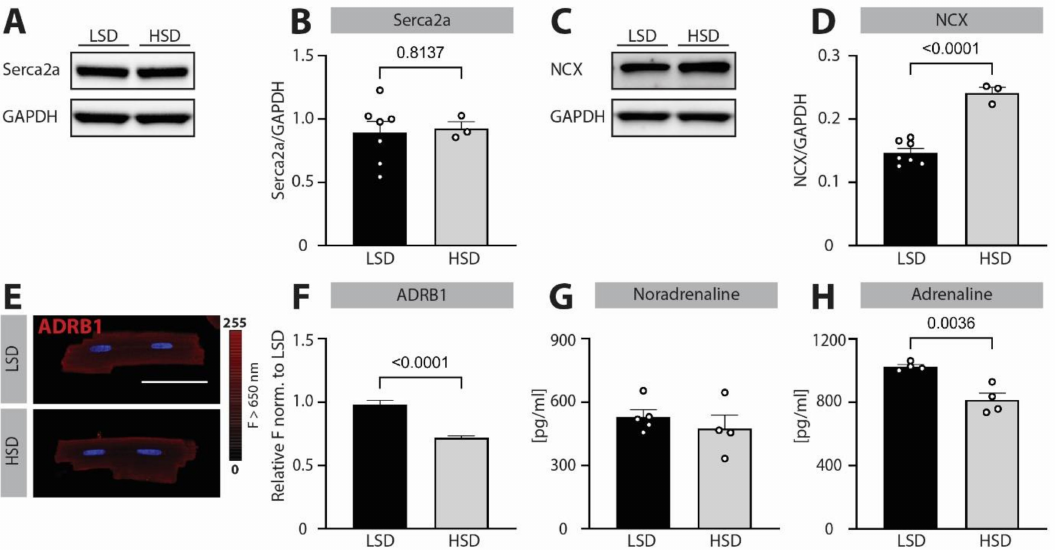
Figure 4. Hypertension is associated with blunted β -adrenergic signaling and increased NCX expression in Dahl salt-sensitive rats . ( A ) Representative bands of immunoblotted Serca2a and housekeeping protein GAPDH in cardiac tissue of Dahl salt-sensitive rats kept on low-salt diet (LSD) or high-salt diet (HSD) for 10 weeks. ( B ) Corresponding quantification of Serca2a expression, normalized to GAPDH. ( C ) Representative bands of immunoblotted NCX and housekeeping protein GAPDH in cardiac tissue of Dahl salt-sensitive rats kept on LSD or HSD for 10 weeks. ( D ) Corresponding mean values of NCX expression, normalized to GAPDH. ( E ) Representative fluorescent images of isolated cardiomyocytes immunostained against β -adrenergic receptor 1 (ADRB1). Scale bar indicates 50 µ m. ( F ) Mean fluorescent values for ADRB1 normalized to LSD. Mean values for ( G ) noradrenaline and ( H ) adrenaline plasma levels in Dahl salt-sensitive rats kept on LSD or HSD for 10 weeks. Data are shown as mean ± SEM ( N = 7/3 rats for LSD/HSD for B and D, N = 2/2 rats and n = 76/79 cells for LSD/HSD and N = 4–5/4 rats for LSD/HSD). Indicated p -values were calculated using